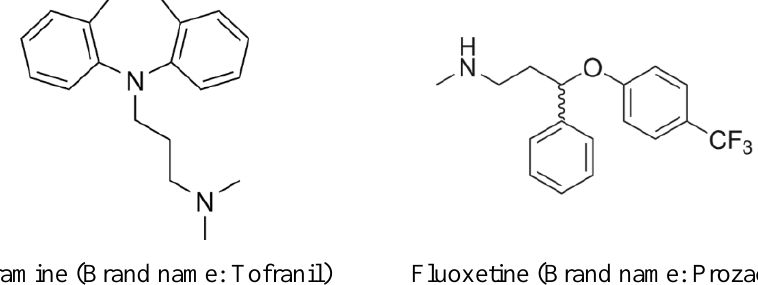
Fig. 1. The molecular structure of fluoxetine and imipramine